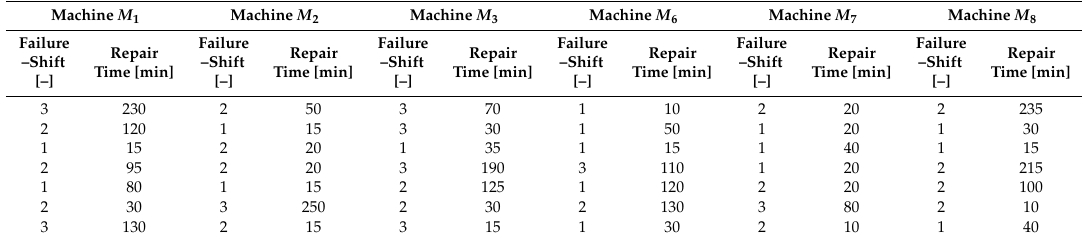
Table 2. Machine failure and repair time data implemented in the scheduling solution.